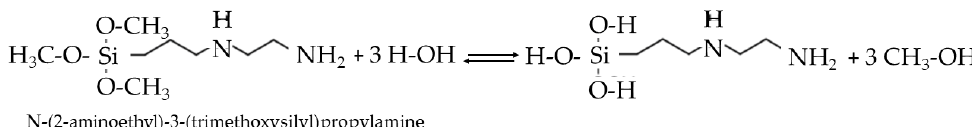
Figure 4. Epoxy group reaction with primary amine. Figure 5. Synthesis of epoxy resin — ORMOSIL. The surface-cleaned metals are immersed in the finished solution with or without the nano-containers six times at, e.g., a 32 cm/min speed and remain in the diathesis for one minute. Then, the coatings are heated at 70 °C for four days. Figure 6 shows the reactions occurring in this process.